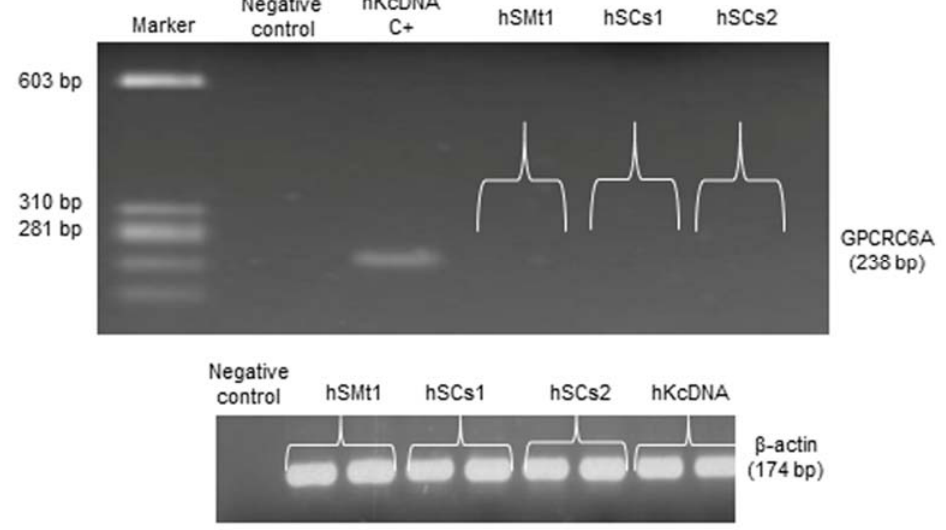
Figure 9. RT-PCR analysis of GPRC6A gene in hSMts and in established hSC lines. Analysis shows the absence of expression of GPRC6A in hSMts and established hSC lines. Commercial human kidney cDNA (hKcDNA) was used as positive control. The negative control was a PCR without templated cDNA.